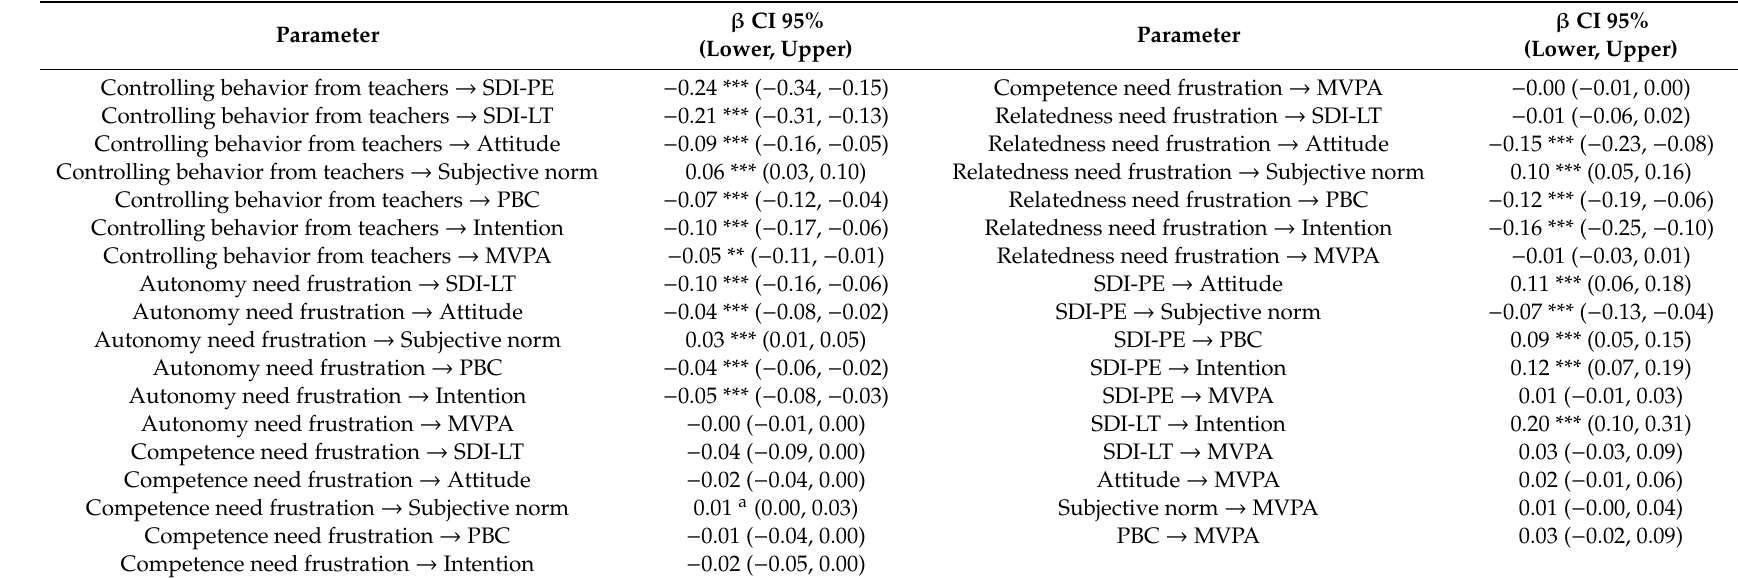
Table 3. Standardized indirect e ff ects in the